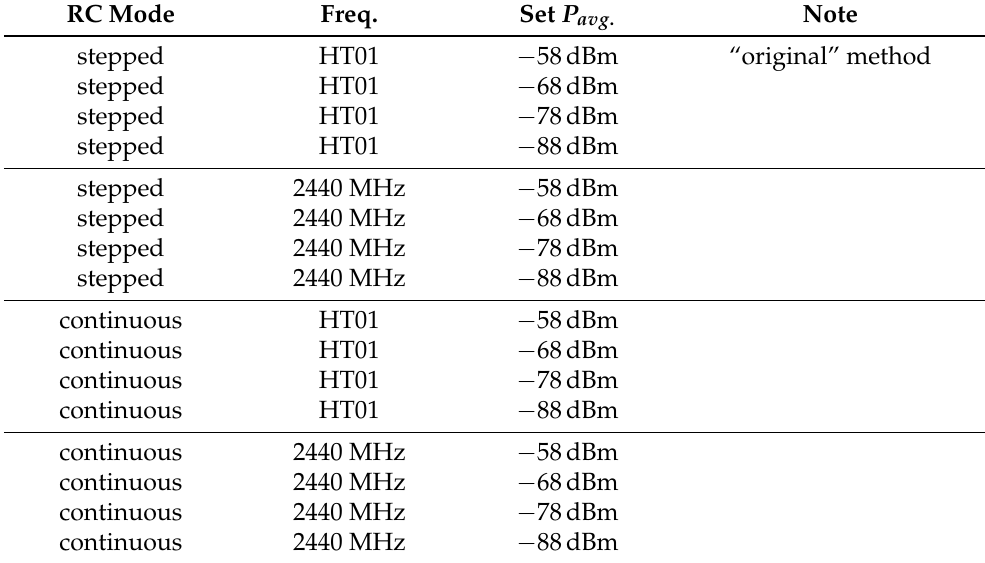
Table 4. Evaluated variants of the MCPE